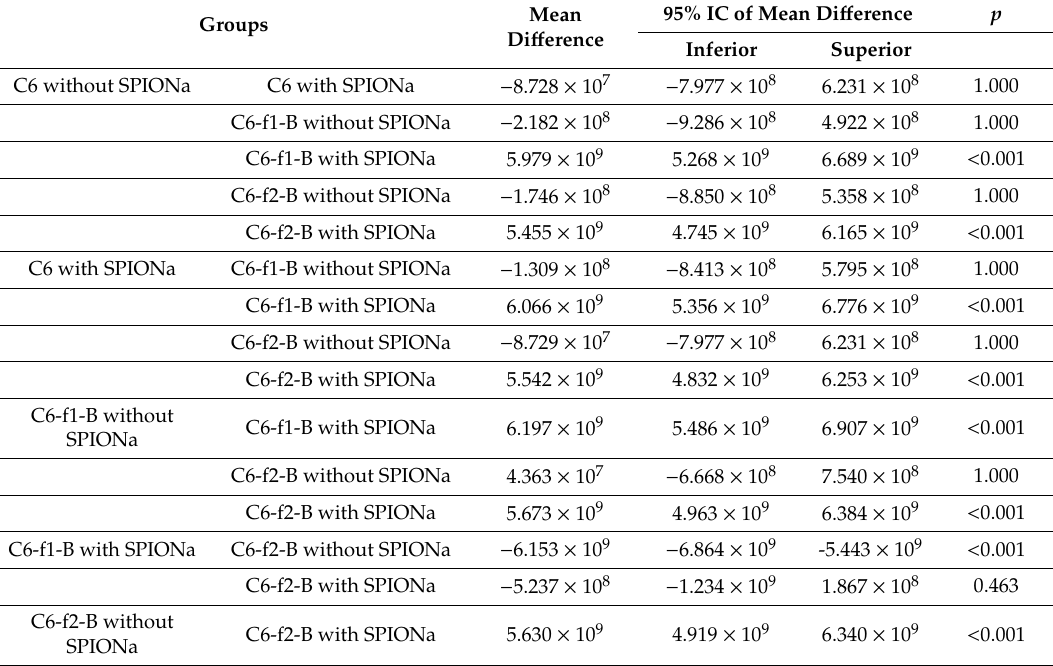
Table A4. Post Hoc analysis of the BLI signal of experimental groups in the third MHT